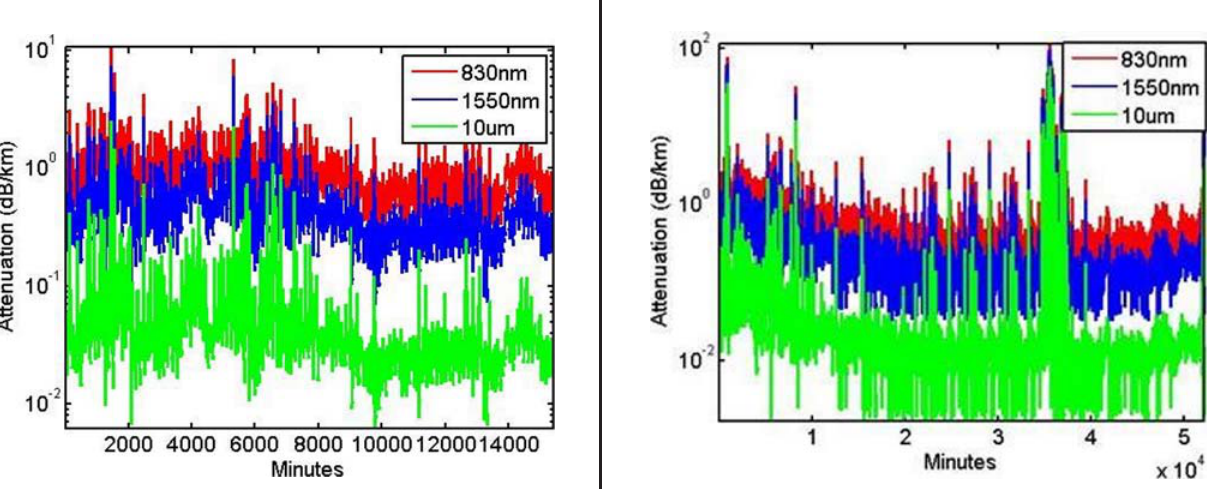
FIG. 3. TIME SERIES PLOT OF ESTIMATED SPECIFIC OPTICAL ATTENUATION BY KIM MODEL FOR 2009